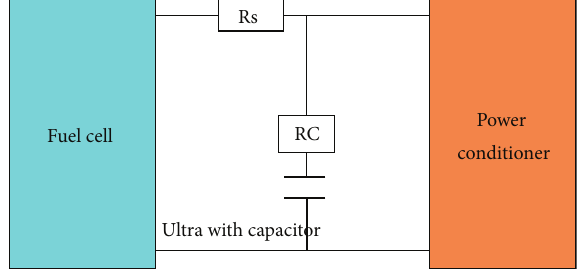
Figure 3: Capacitor bank in parallel with FC.